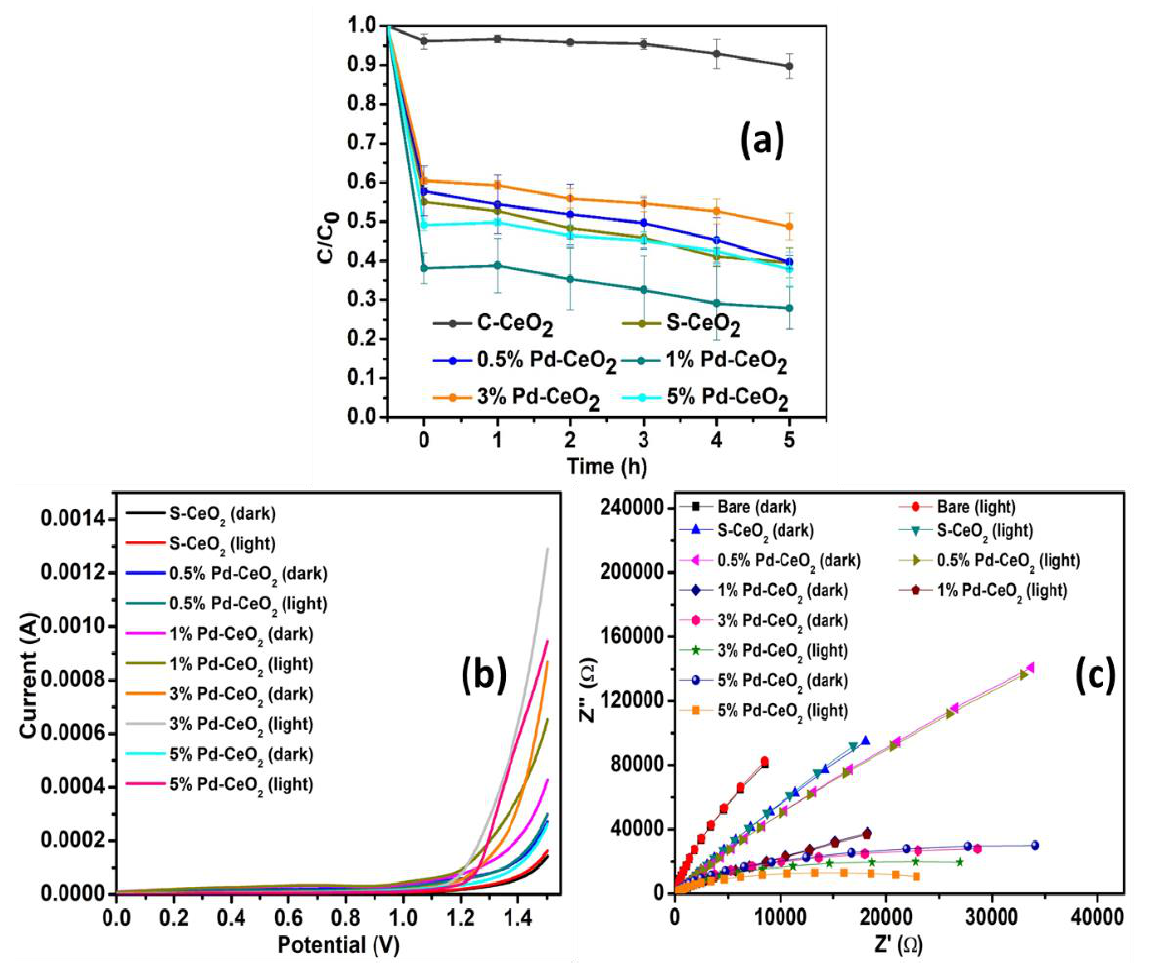
Figure 6. ( a ) The average C/C 0 of photocatalytic degradation of MB using C − CeO 2 , S − CeO 2, and Pd − CeO 2 NPs under visible light irradiation, ( b ) LSV, and ( c ) EIS Nyquist plots of S − CeO 2 , 0.5%, 1%, 3%, and 5% Pd − CeO 2 photoelectrode in the dark and under visible light irradiation. Table 4. The average percentage MB dye degradation using C − CeO 2 , S − CeO 2, and Pd − CeO 2 under visible light irradiation.